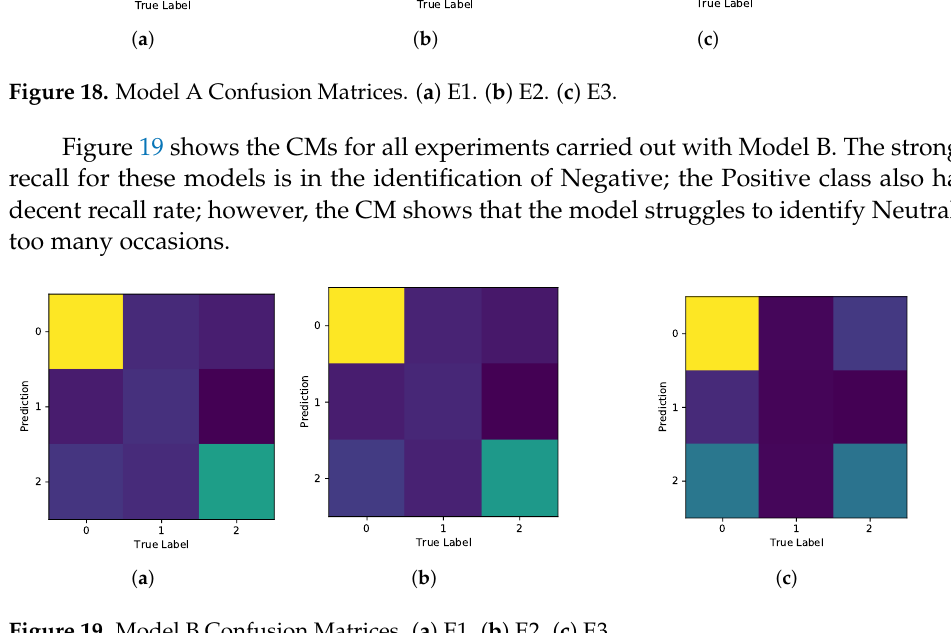
Figure 19. Model B Confusion Matrices. ( a ) E1. ( b ) E2. ( c )